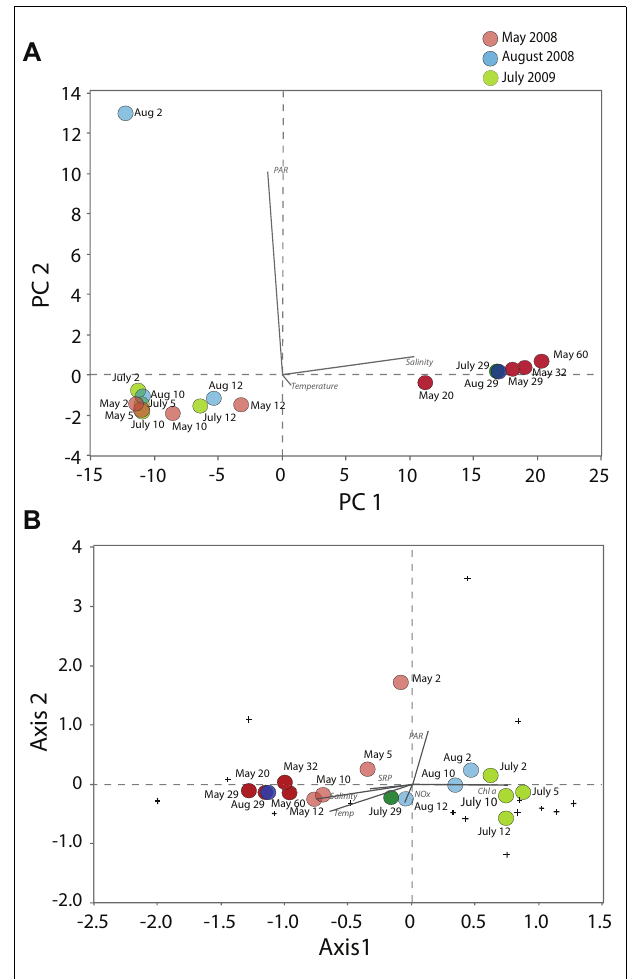
FIGURE 6 | Principal component analysis (A) based on non-transformed environmental variables (temperature, salinity, PAR, NOx, SRP, chlorophyll a ), and canonical correspondence analysis (B) using sequence proportions of all genera and the same environmental variable. Samples from the mixolimnion are represented in light hues and from the monimolimnion in dark hues. Samples of May 2008 are in red, August 2008 in blue and July 2009 in green. Note that the loadings for the nutrient and chlorophyll a variables are not indicated in the tri-plot (A) because they were not significantly different from